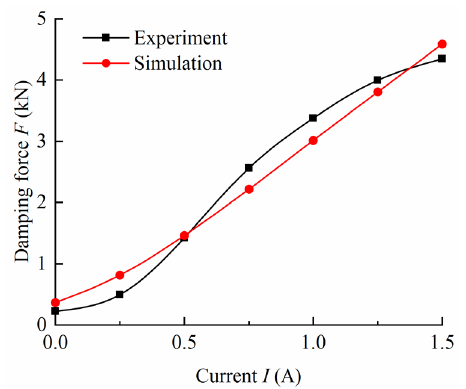
Figure 17. Simulated and experimental damping force under different applied currents.